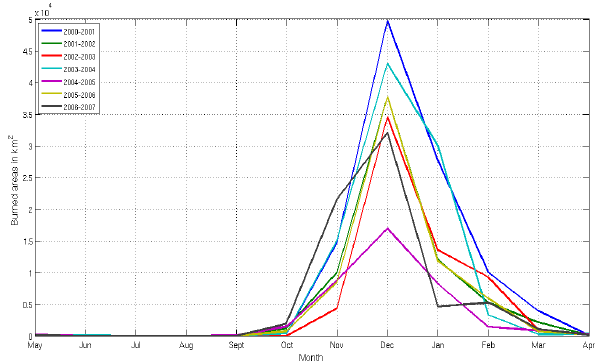
Figure 2. Intra-annual variability in burned areas at the regional scale over West Africa between 1 April 2000 and 31 March